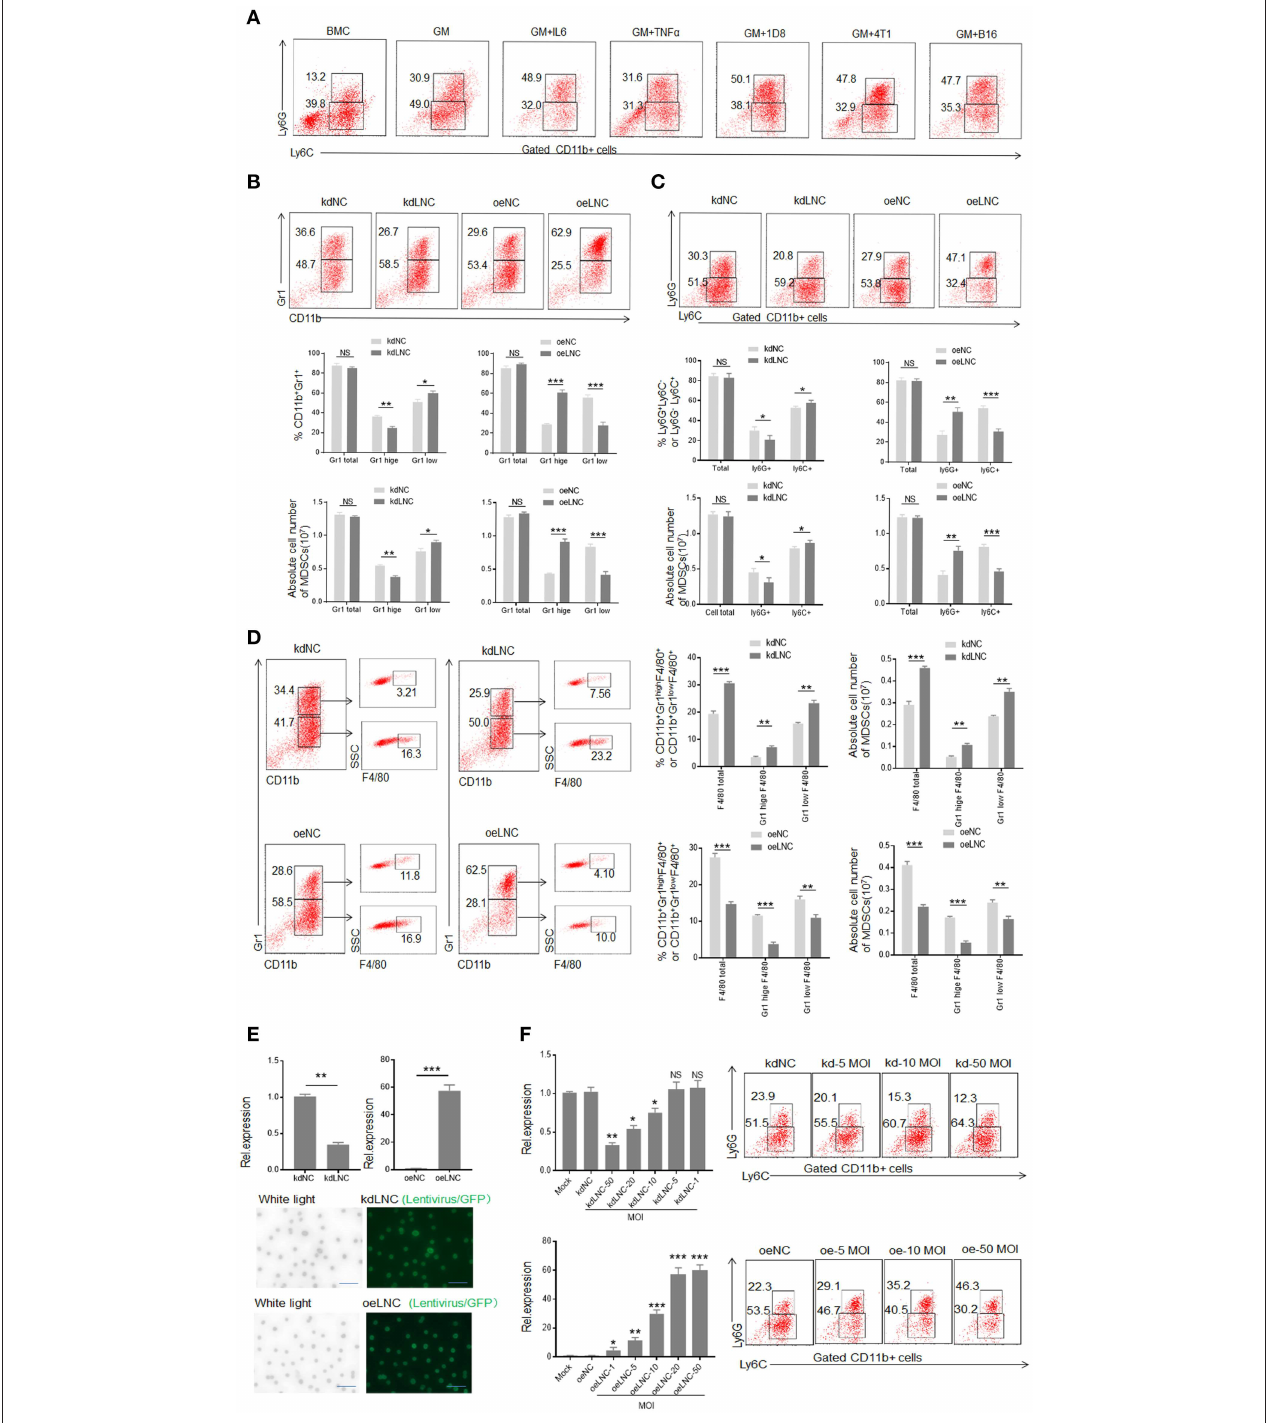
FIGURE 2 | Lnc-C/EBP β promotes differentiation of PMN-MDSC but impedes Mo-MDSC in vitro . (A) Flow cytometry of inflammatory cytokine and tumor mediated CD11b + Ly6G + Ly6C − and CD11b + Ly6G − Ly6C + MDSCs. 1D8, mouse ovarian carcinoma; 4T1, mouse breast cancer; B16, mouse melanoma. BMC, bone marrow cells; GM, GM-CSF. (B) Flow cytometry of Gr1 + CD11b + , Gr1 hi CD11b + , and Gr1 low CD11b + MDSCs in lnc-C/EBP β knockdown or exogenous lnc-C/EBP β treated MDSCs. The percentages and absolute number of cells were compared ( n = 3). (C) Flow cytometry of CD11b + Ly6G + Ly6C − and CD11b + Ly6G − Ly6C + MDSC in lnc-C/EBP β knockdown or exogenous lnc-C/EBP β treated MDSCs. The percentages and absolute number of cells were compared ( n = 3). (D) Flow cytometry of